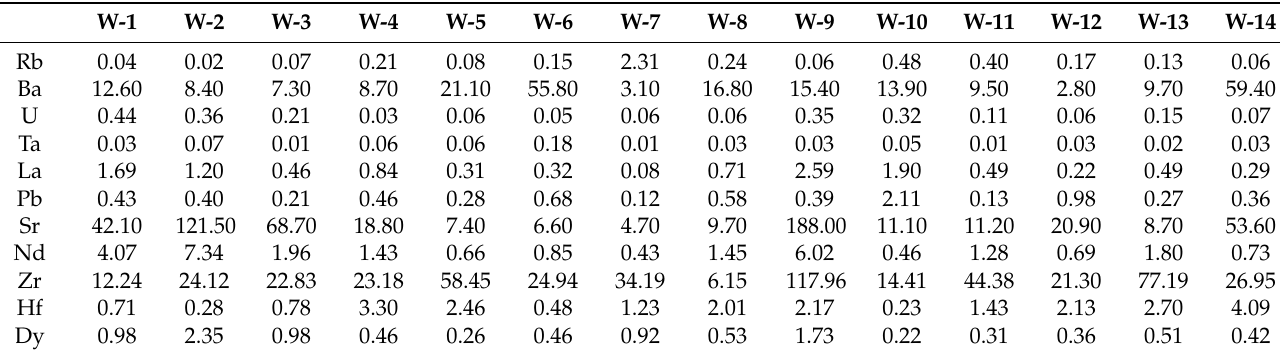
Table 3. Guatemalan jadeite trace elements